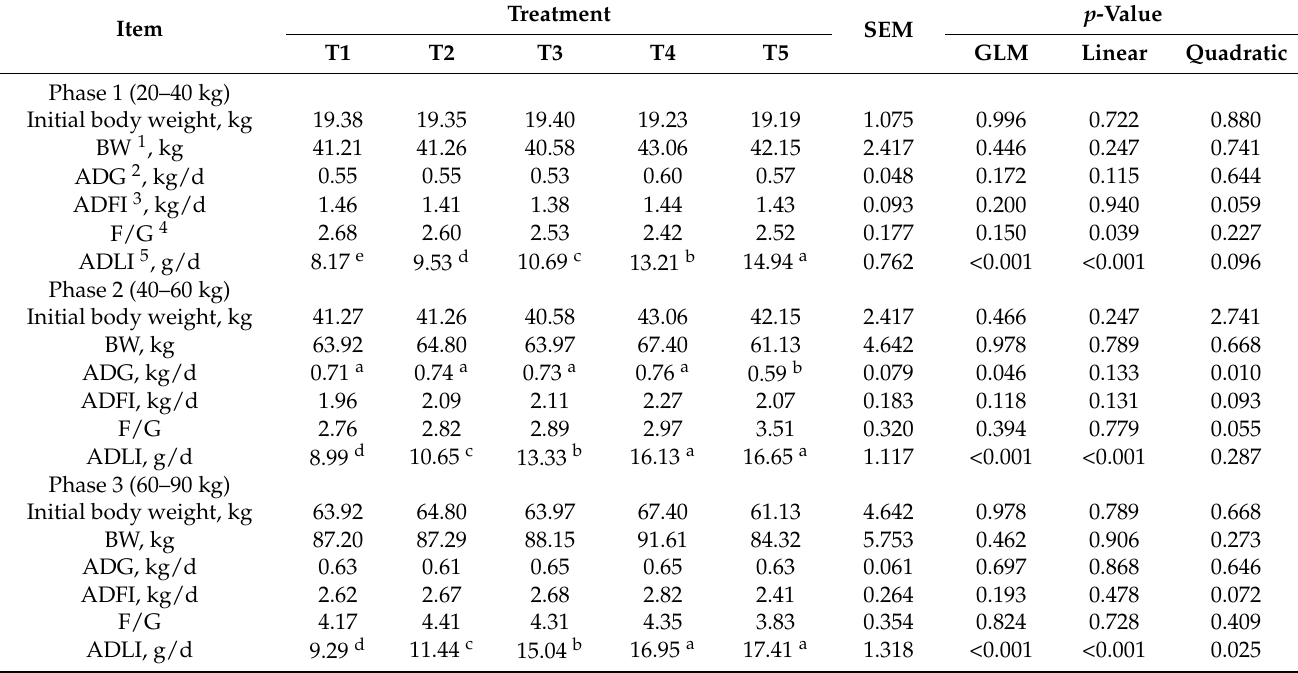
Table 3. Effect of dietary SID lysine levels on growth performance of Baqing pigs at 20–90 kg.